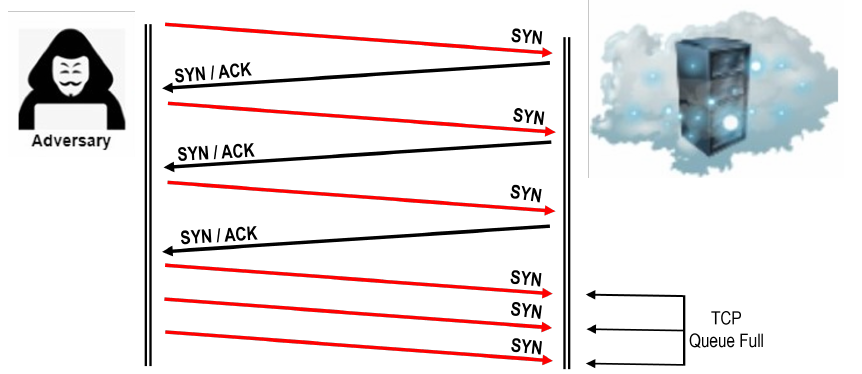
Figure 4. SYN flood